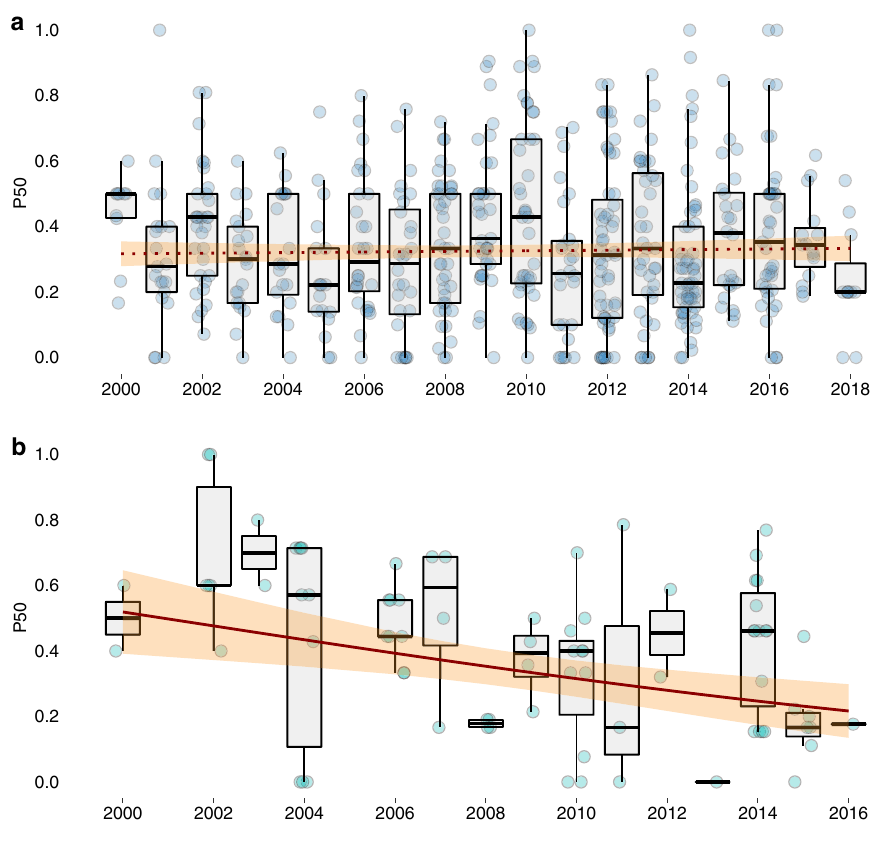
Fig. 1 Annual trends in the proportion of drugs with resistance greater than 50% (P50) in each survey. ( a ) P50 for cultured aquatic animals ( n = 558); and ( b ) wild-caught aquatic animals ( n = 81). The horizontal box lines represent the fi rst quartile, the median, and the third quartile. Whiskers denote the range of points within the fi rst quartile − 1.5× the interquartile range and the third quartile + 1.5× the interquartile range. Each survey is represented by a dot with horizontal jitter for visibility. Regression lines are fi tted using generalized linear models, with a solid line indicating statistical signi fi cance ( p = 0.003); 95% con fi dence intervals are shown in shaded